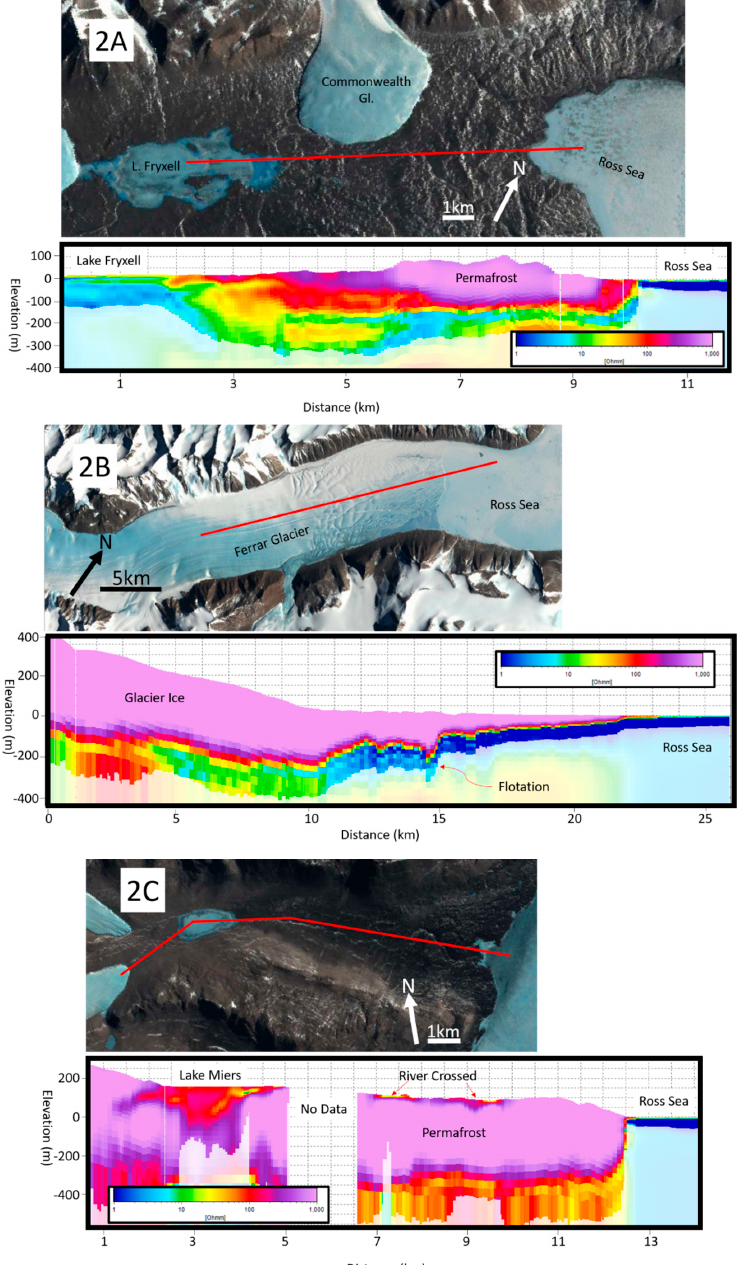
Figure 2. ( A ) AEM cross section of Lower Taylor Valley showing the connection between Lake Fryxell and the Ross Sea by a talik and conductive aquifer. Low resistivity regions are interpreted as liquid brines; ( B ) AEM cross section of Ferrar Glacier showing subglacial brine connecting to the Ross Sea; and ( C ) AEM cross section of Miers Valley. Brine can be detected underneath thick permafrost, and this brine appears to be in contact with the Ross Sea.